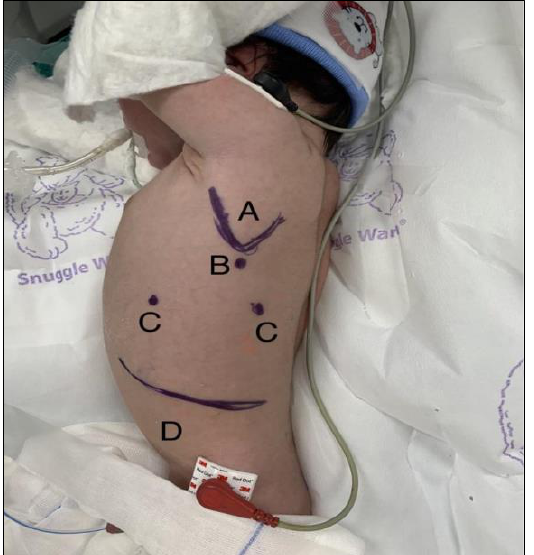
Figure 1: The patient was placed on right lateral decubitus, working ports are marked. A. Scapula; B. 3mm lens; C. 3 mm trocars; D- Reverdin needle insertion site.